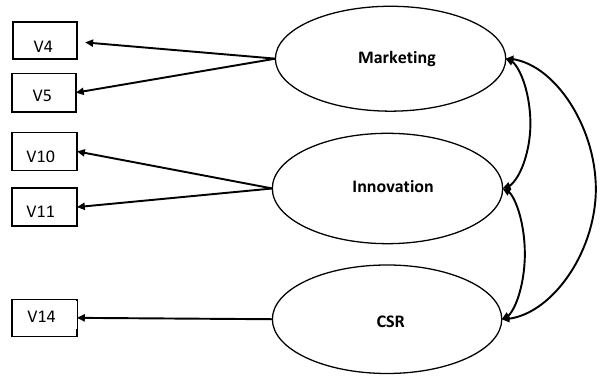
Fig. 3 – Factor model of sources of enterprise competitive advantage. Source: own research The individual observable variables (positions on the scale) are represented as rectangles and the factors as ovals in Figure 2. The life-and-death (regressive) relations are shown with unidirectional arrows and correlation dependences by means of bidirectional arrows.